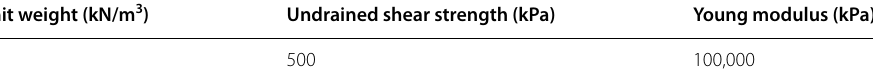
Table 2 The properties of the CDM zone [3, 20] Unit weight (kN/m 3 )